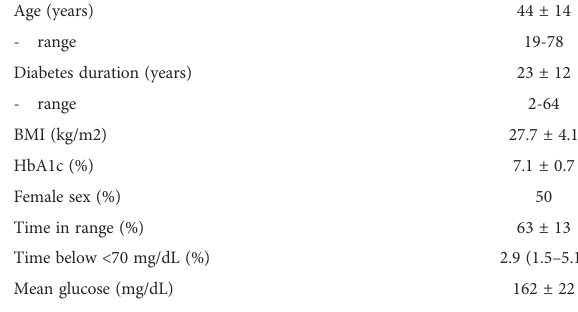
TABLE 1 patients characteristics presented as mean ± standard deviation for parametric characteristics or Median (interquartile range) for